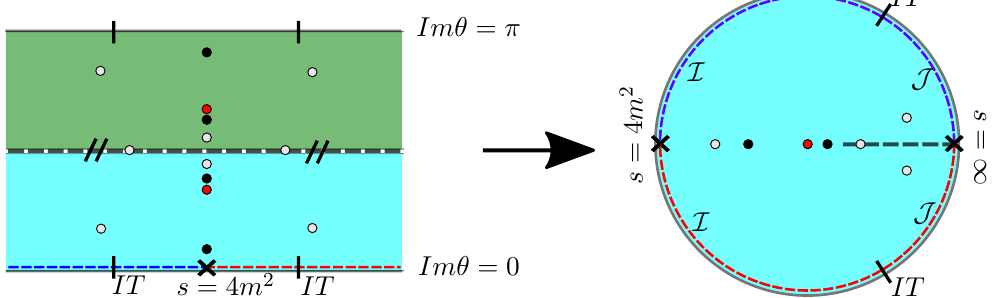
Figure 3. Mapping from the θ -plane (left) to the z -disc (right). The red dots, representing the self-coupling pole, are mapped to the center of the z -disc. Other typical poles are represented by black dots, whereas typical zeros are represented by grey dots. The particle production threshold is indicated by the black